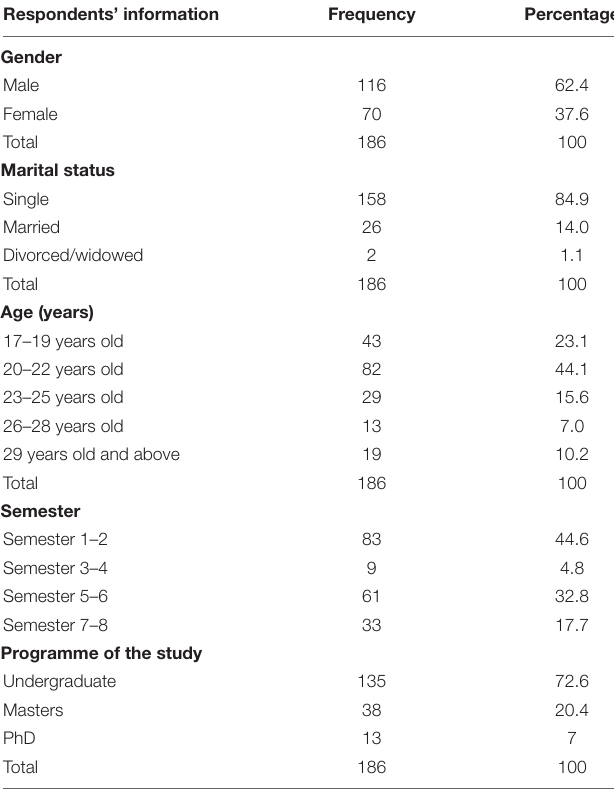
TABLE 2 | Demographic profile of the respondents.